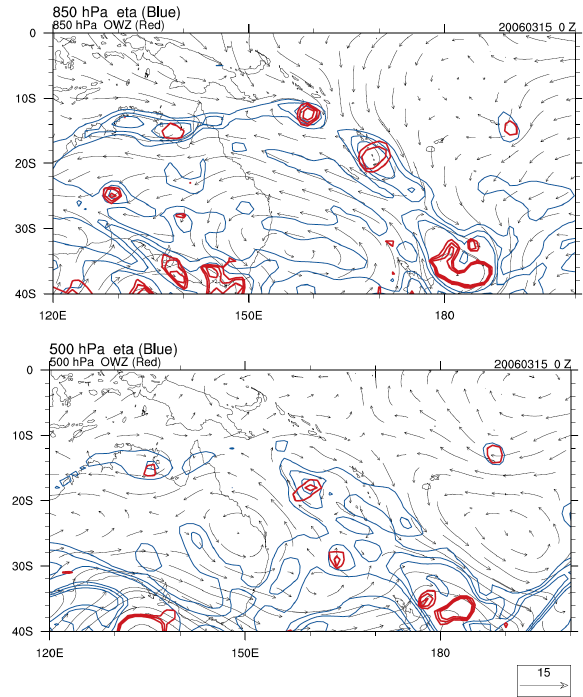
Figure 4. ERA-interim absolute vorticity (blue contours, -60, -80, -100 6 1 10 s − − × ), OWZ (red 4 Fig. 4. ERA-interim absolute vorticity (blue contours, − 60, − 80, contours, 60, 80, 100 6 1 10 s − − × ) and horizontal winds (vectors) on 850 hPa (upper panel) and 500 5 − 100 × 10 − 6 s − 1 ) , OWZ (red contours, 60, 80, 100 × 10 − 6 s − 1 ) hPa (lower panel) pressure levels, at 00 UTC 15 March 2006 (48 hours prior to the formation of 6 and horizontal winds (vectors) on 850hPa (upper panel) and TC Larry). The TC Larry precursor is located at about 12° S, 160° E. 7 500hPa (lower panel) pressure levels, at 00:00 UTC 15 March 2006 (48 h prior to the formation of TC Larry). The TC Larry precursor is located at about 12 ◦ S, 160 ◦